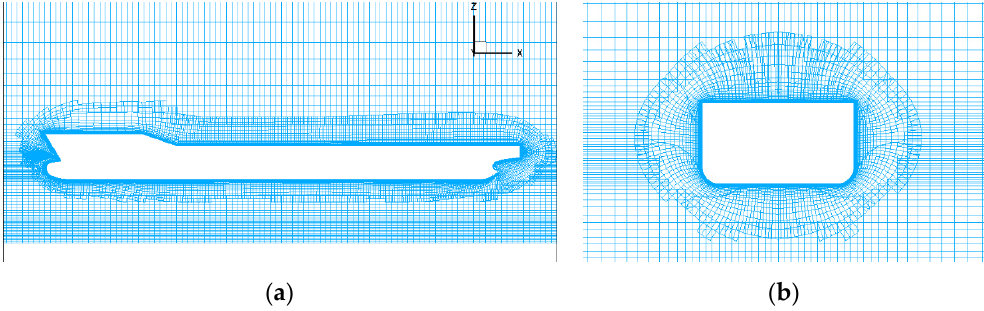
Figure 8. 2D mesh sections: ( a ) midsection in the Y = 0 plane and ( b ) midsection in the X = 0.5L PP plane.